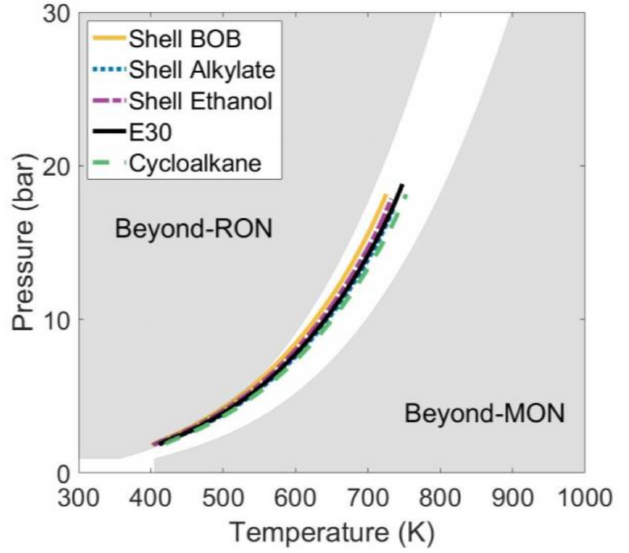
Figure 9. Pressure-Temperature trajectories for SACI at 5 ◦ CA phasing, plotted up to the spark event. The cylinder pressures and heat release rates that correspond to the PT trajectories shown in Figure 8; Figure 9 are shown in Figure 10 for the same fuels and combustion phasing conditions. For PFS operation, cylinder pressures prior to combustion were